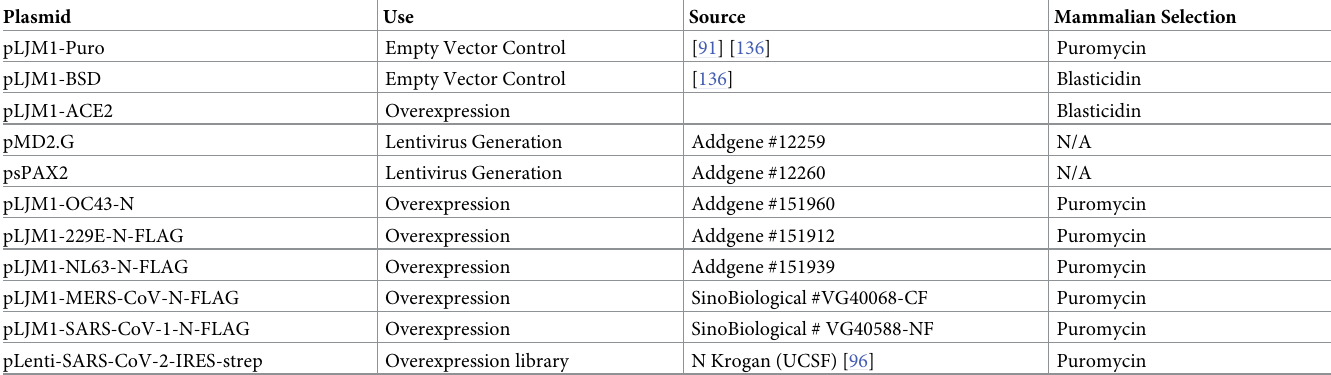
Table 1. Plasmids.